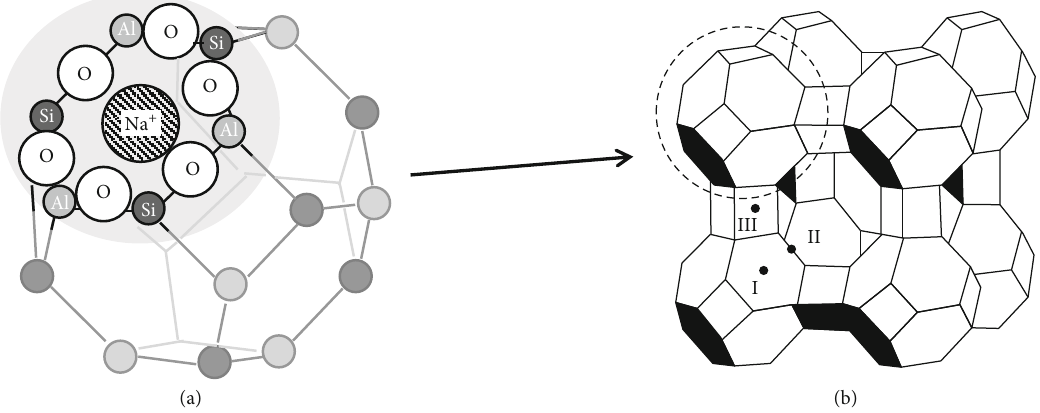
Figure 1: Schematic view of (a) a sodalite cage and (b) an α -cage surrounded by eight sodalite